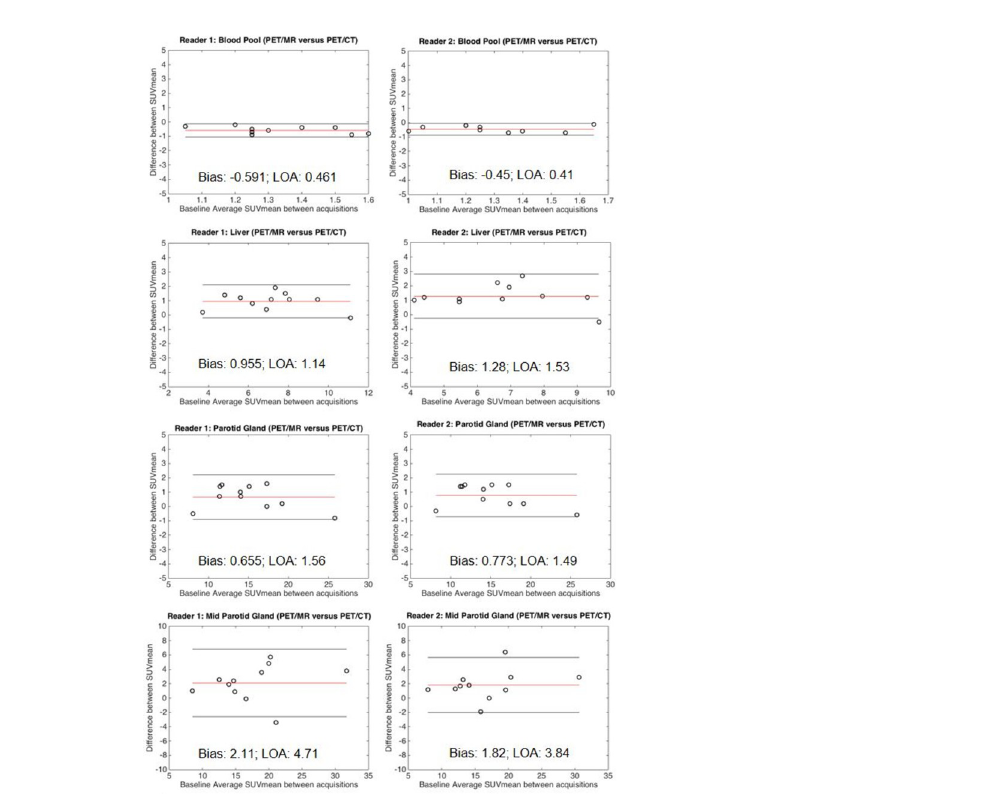
Fig 4. Bland Altman analysis assessing inter-modality variability between PET/CT and PET/MR acquisitions. A slight bias of decreased SUV mean for blood pool (top) and increased SUV mean for liver (middle) and parotid gland (bottom) was seen for wbPET/MR compared to wbPET/CT regardless of reader. The calculated bias (red line) as well as the upper and lower limits of agreement (outer black lines) are demarcated on each plot. The bias and limits of agreement are listed in the